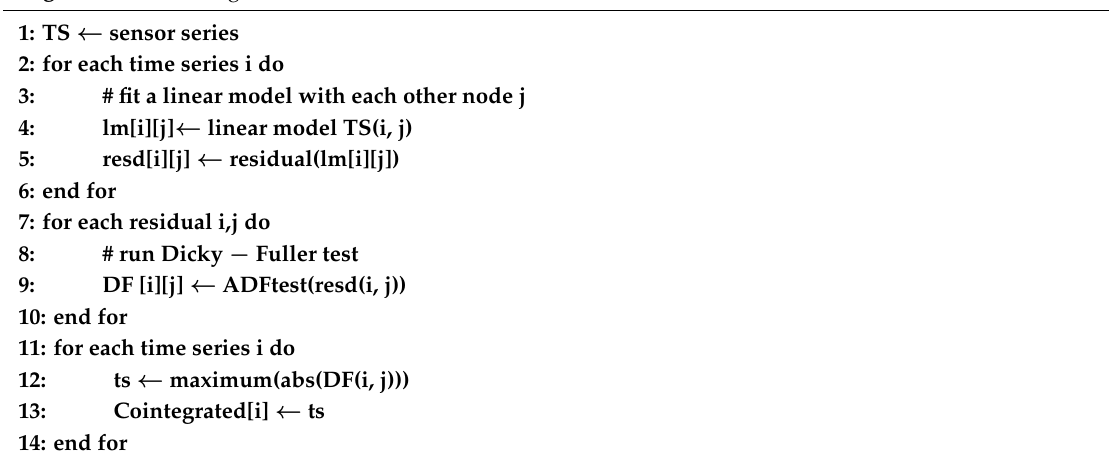
Algorithm 1: Co-integrated time series